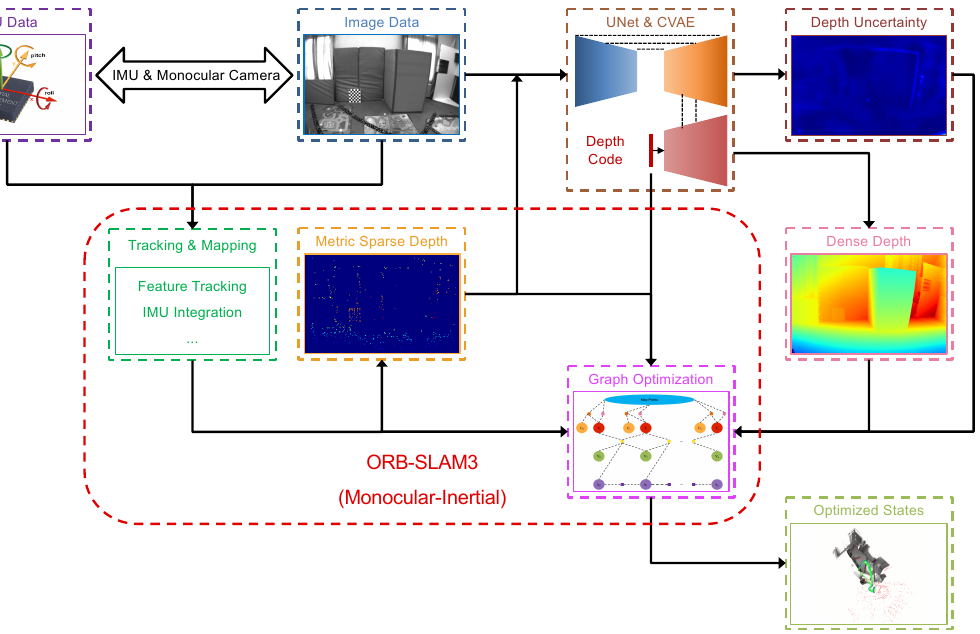
Figure 2. System overview of our proposed framework. The system is based on ORB-SLAM3 in the monocular visual-inertial modality with a tightly-coupled back-end based on graph optimization by considering visual, inertial, and depth residuals. RGB/gray images and projected sparse depth images derived from the geometric SLAM are taken as the inputs for the network